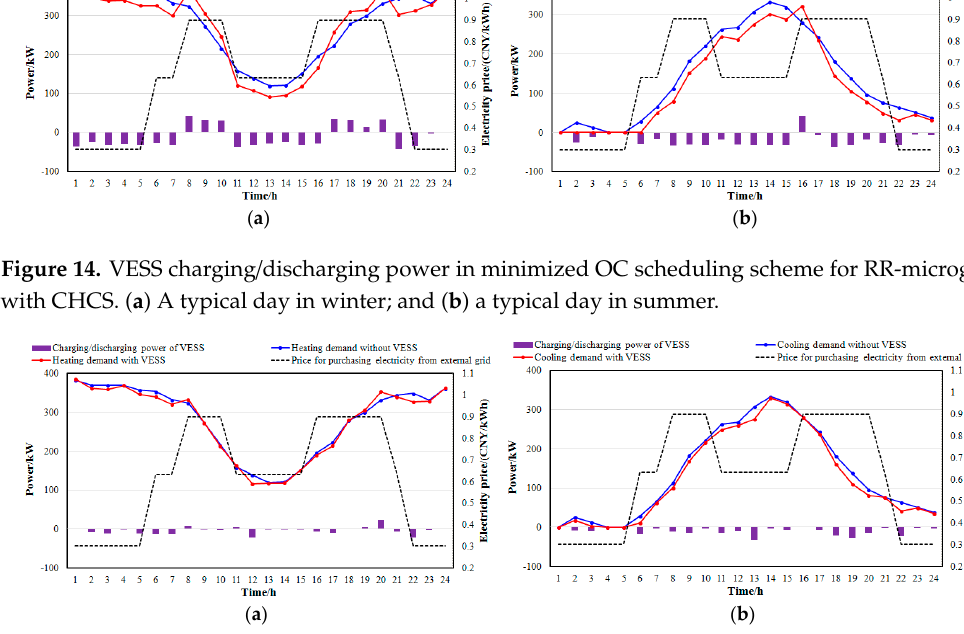
Figure 15. VESS charging / discharging power in best scheduling scheme for RR-microgrid with CHCS. ( a ) A typical day in winter; and ( b ) a typical day in